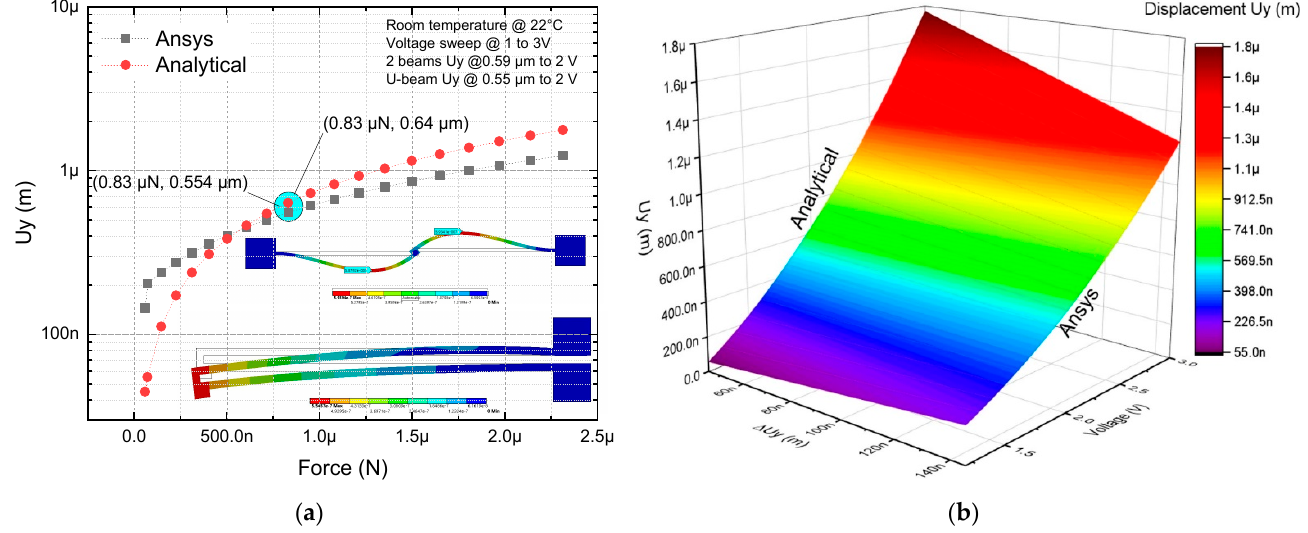
Figure 7. Analytical and numerical models result for microactuators of two beams and U-beam-like actuator: ( a ) 2D and ( b ) 3D representations.